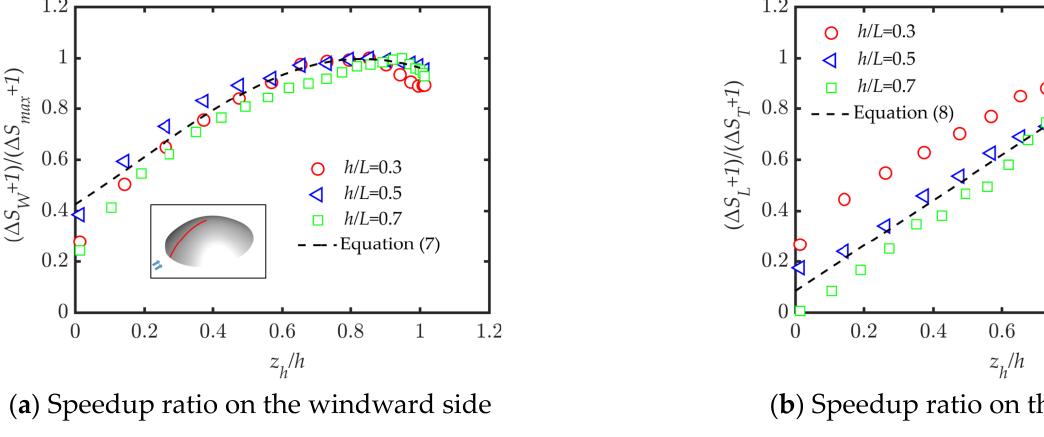
Figure 12. Speedup ratio of different slopes ( Z / h = 0.0133). The variation of the speedup ratio at the hilltop with slope is shown in Figure 13. When the slope is less than 0.5, the speedup ratio at each position increases linearly with the increase in slope. When the slope is greater than 0.5, the speedup ratio decays in a quadratic curve shape with the increase of slope. The specific expression is shown in Equa- tion (10).